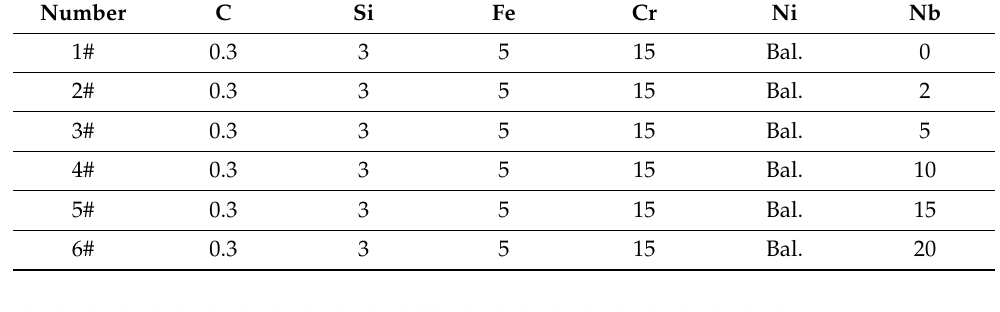
Table 2. Chemical composition of Ni-based alloy powders (wt%).